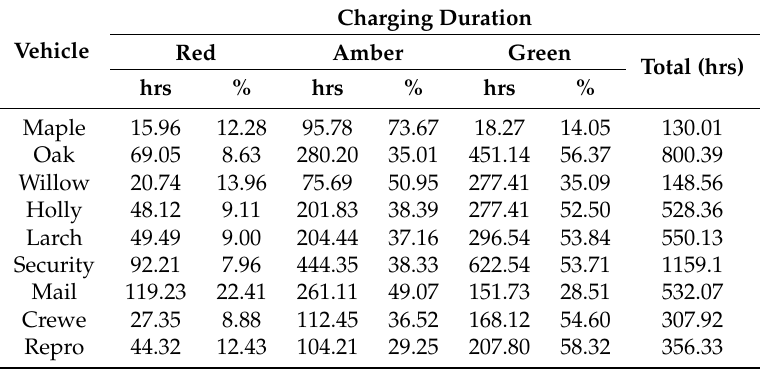
Table 3. Tariff period of charging by vehicle.